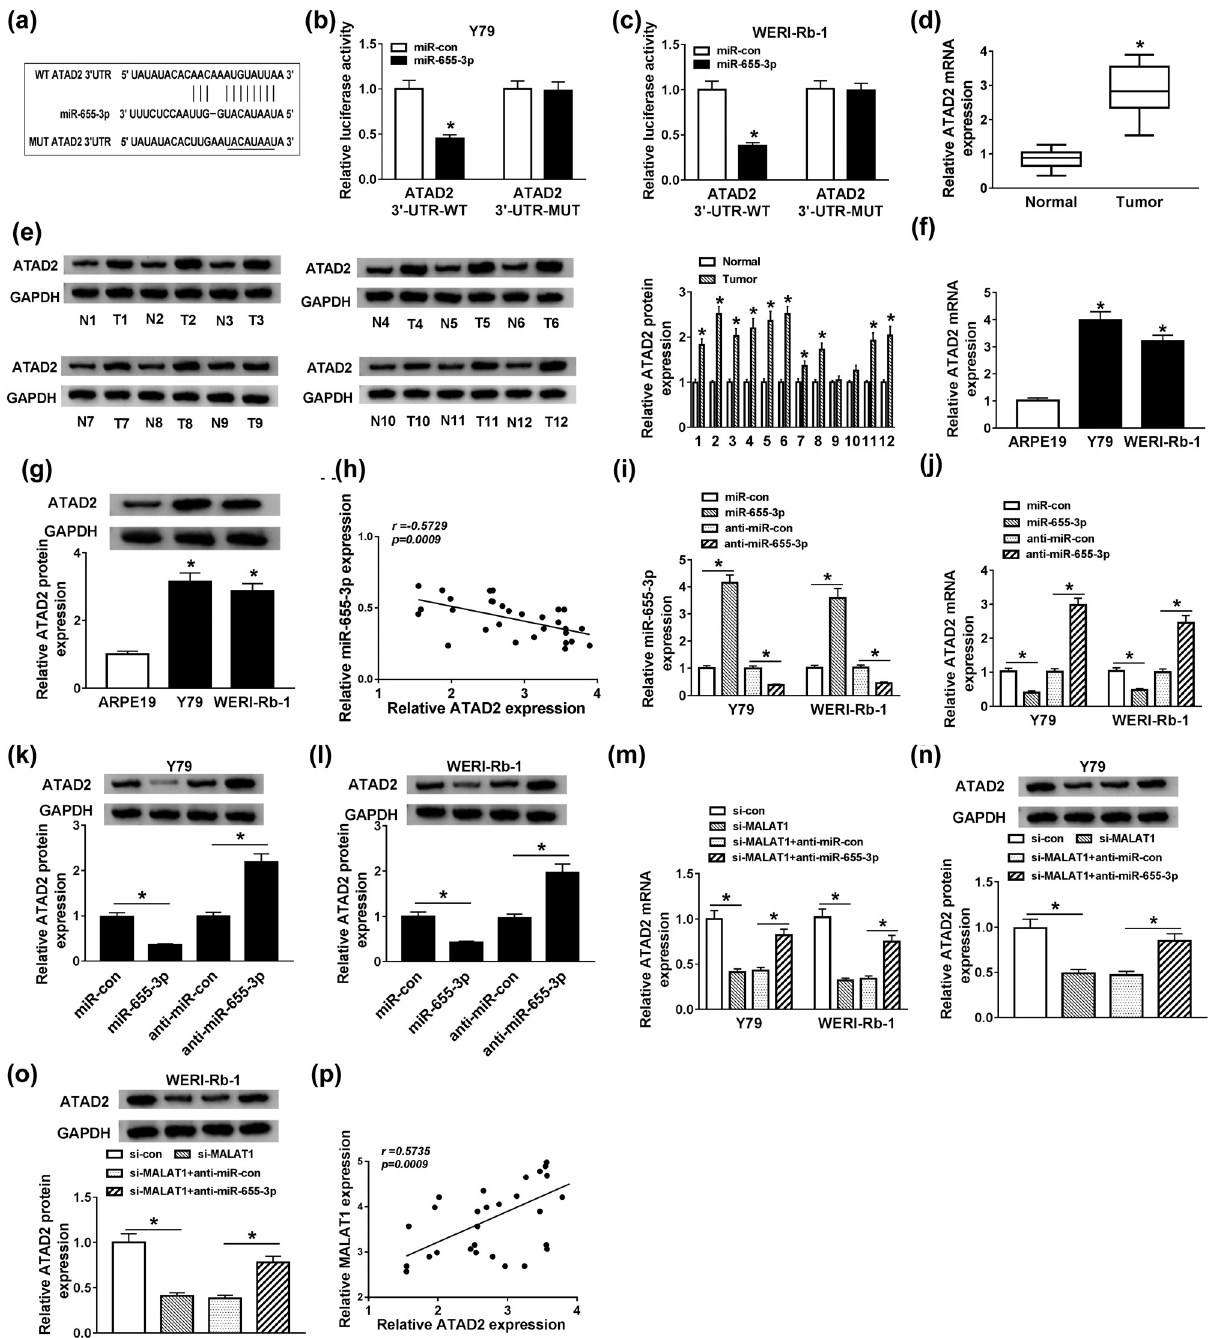
Figure 5: MALAT1 upregulated ATAD2 expression by repressing miR - 655 - 3p in Y79 and WERI - Rb - 1 cells. ( a ) Putative or mutant binding sites of miR - 655 - 3p in the ATAD2 3 ′ - UTR were predicted by StarBase. ( b and c ) The luciferase activity of Y79 and WERI - Rb - 1 cells co - transfected with WT - ATAD2 or MUT - ATAD2 and miR - 655 - 3p or miR - con for 48 h was evaluated by dual - luciferase reporter assay. ( d ) The mRNA level of ATAD2 in RB and normal tissues was detected by RT - qPCR. ( e ) The protein levels of ATAD2 in 12 RB and normal tissues were exposed by western blot assay. ( f and g ) The mRNA and protein levels of ATAD2 in RB cells ( Y79 and WERI - Rb - 1 ) and retinal pigment epithelial cells ARPE19 were uncovered by RT - qPCR and western blot assay, respectively. ( h ) The correlation between miR - 655 - 3p and ATAD2 was processed by Pearson ’ s correlation analysis. ( i – l ) Y79 and WERI - Rb - 1 cells were co - transfected with miR - con, miR - 655 - 3p, anti - miR - con, and anti - miR - 655 - 3p. ( i and j ) After transfection for 24 h, the expressions of miR - 665 - 3p and ATAD2 mRNA were detected by RT - qPCR. ( k and l ) After transfection for 48 h, the protein level of ATAD2 was examined by western blot. ( m – o ) Y79 and WERI - Rb - 1 cells were transfected with si - con, si - MALAT1, si - MALAT1 + anti - miR - con, or si - MALAT1 + anti - miR - 655 - 3p. After transfection for 24 or 48 h, the mRNA and protein levels of ATAD2 were measured via RT - qPCR and western blot assay. ( p ) The correlation between MALAT and ATAD2 was validated by Pearson ’ s correlation analysis. * P <